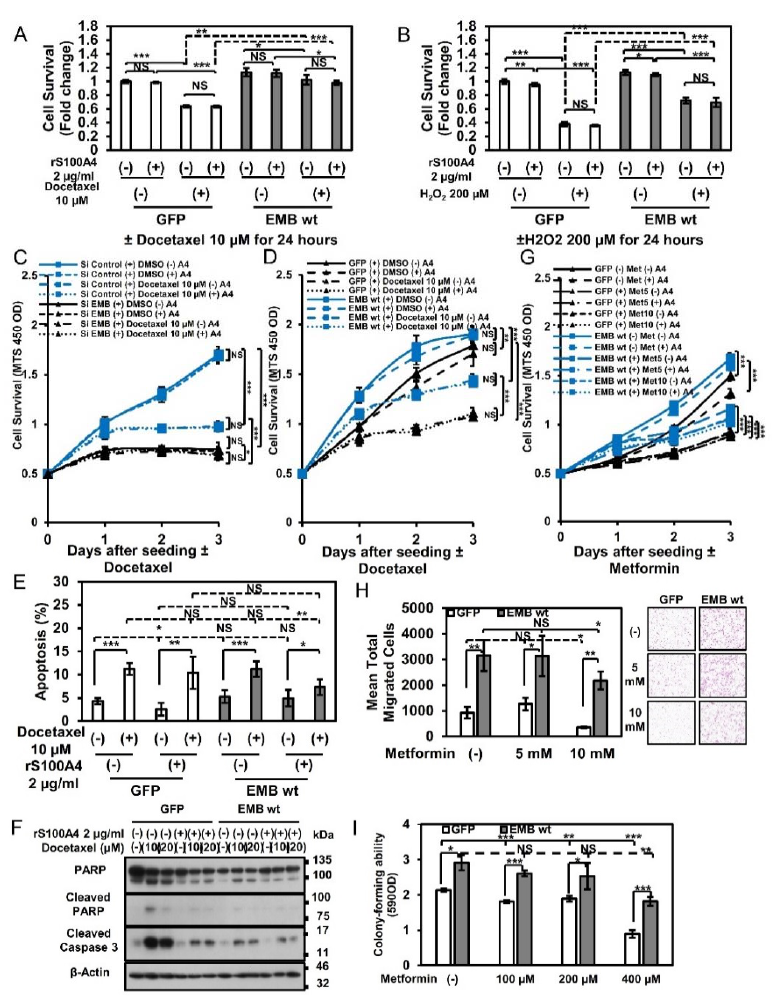
Figure 6. Embigin induces prostate cancer cell survival upon chemotherapy and oxidative